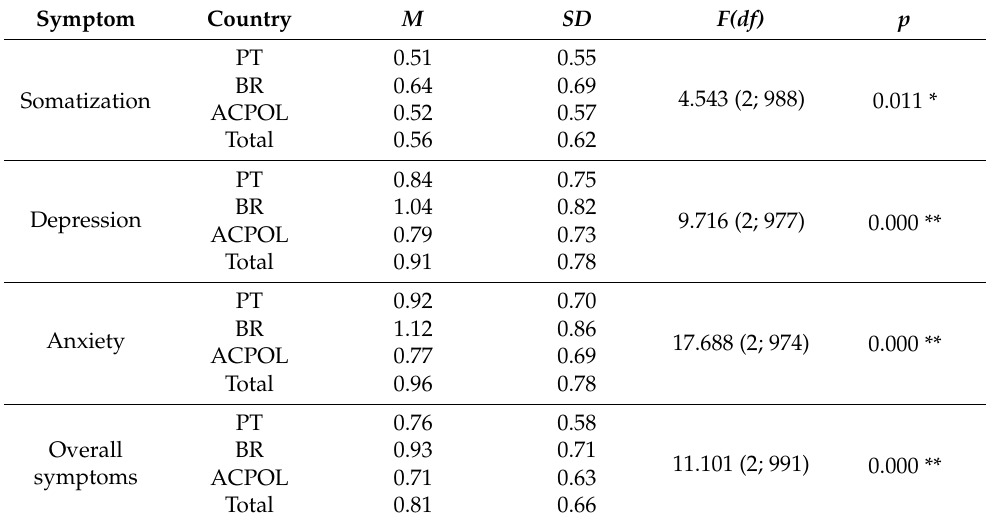
Table 3. Differences in mental health symptoms by country of